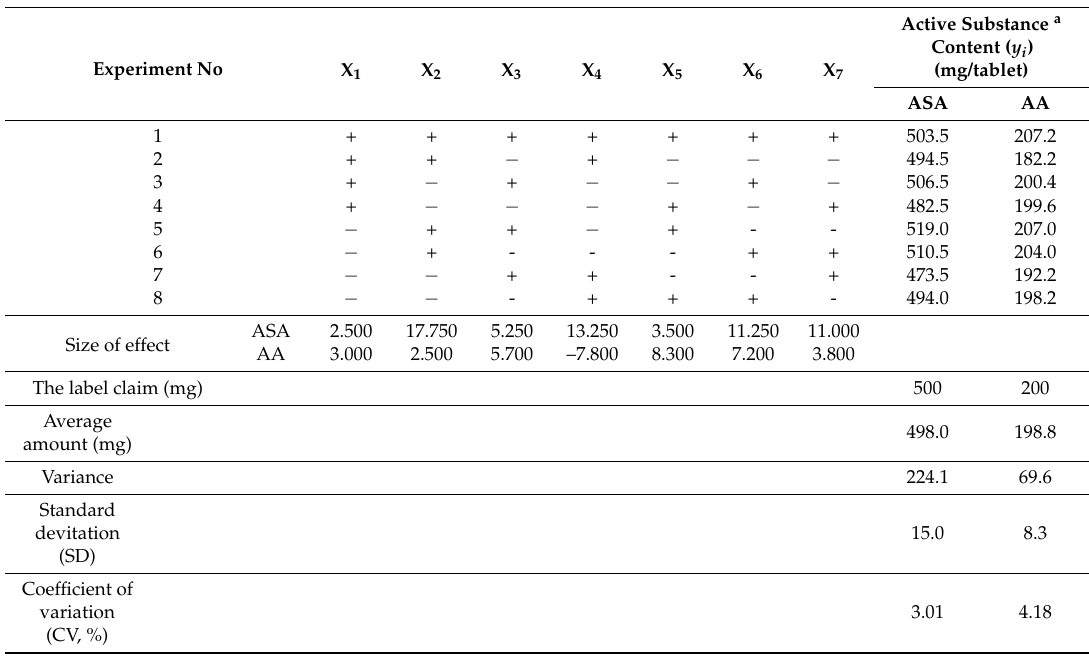
Table 4. The experimental design matrix (2 3 ) for the robustness test for the examined active substances in commercial effervescent tablets.